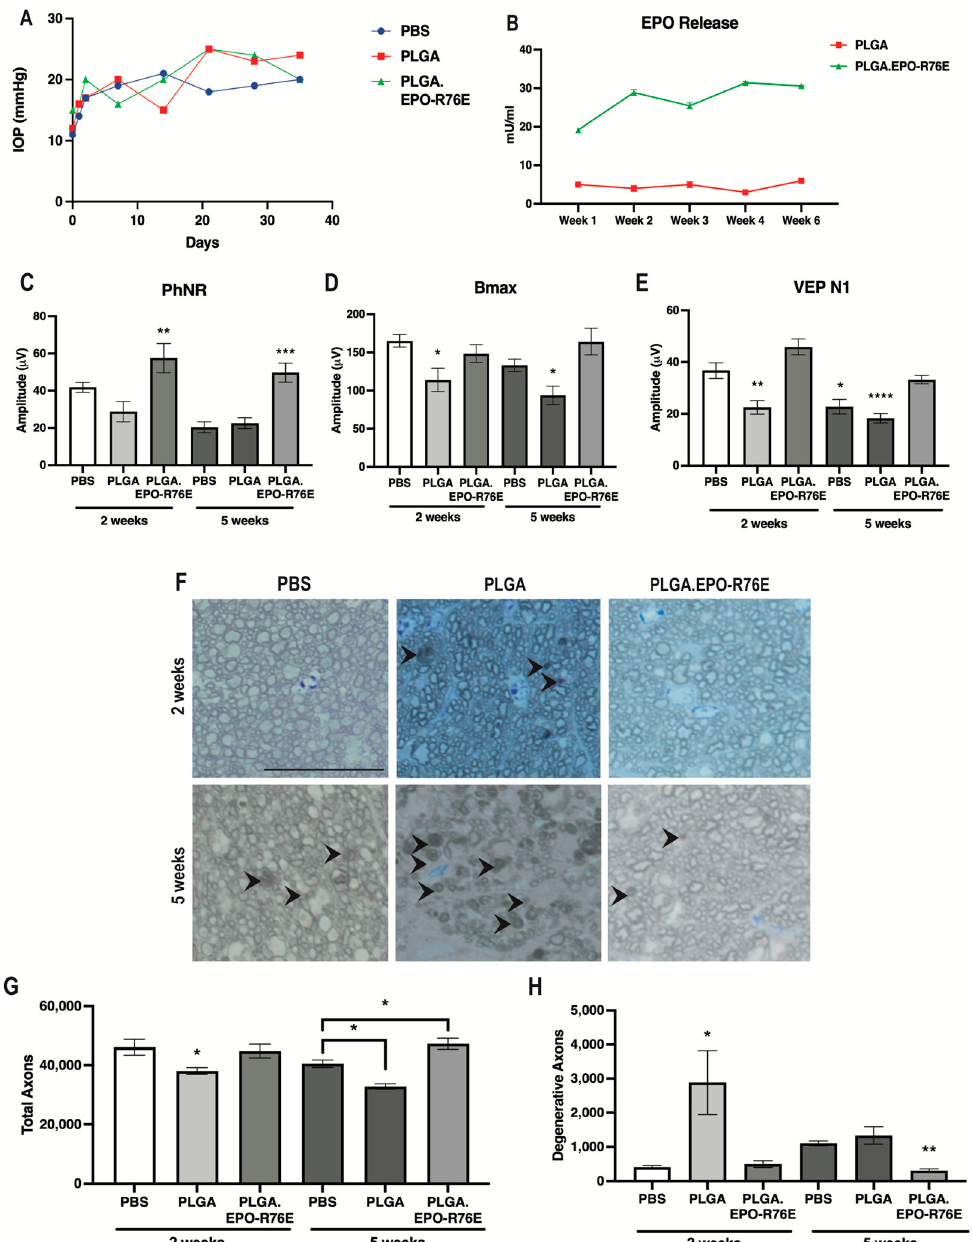
Figure 1. ( A ) IOP levels over time in mice intravitreally injected with PBS, PLGA or PLGA.EPO-R76E. ( B ) Retina EPO levels in PLGA or PLGA.EPO-R76E injected mice at 1, 2, 3, 4, and 6 weeks post-intravitreal injection. ( C ) Quantification of PhNR amplitude of the ERG at 2 and 5 weeks post-IOP elevation for all groups, ** p = 0.01, *** p < 0.001. ( D ) Quantification of b max amplitude of the ERG at 2 and 5 weeks post-IOP elevation for all groups, * p < 0.05. ( E ) Quantification of N1 amplitude of the VEP at 2 and 5 weeks post-IOP elevation for all groups, * p < 0.05, ** p = 0.01. For all electrophysiological data, comparisons were made between all 2 week groups separately from all 5 week groups; unless otherwise indicated, asterisks indicate differences between PLGA.EPO-R76E group and both PBS and PLGA groups. ( F ) Representative micrographs of optic nerves at 2 and 5 weeks post-IOP elevation for all groups. Line represents 20 µm. ( G , H ) Quantification of total and degenerative axons, respectively, in optic nerves at 2 and 5 weeks post-IOP elevation for all groups, * p < 0.05, ** p = 0.01. For all optic nerve data, comparisons were made between all 2 week groups separately from all 5 week groups; unless otherwise indicated, asterisks indicate differences between PLGA.EPO-R76E group and both PBS and PLGA groups.